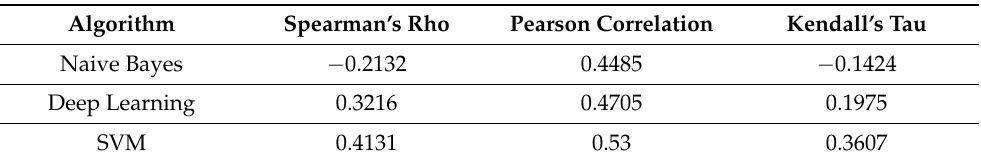
Table 4. The results of validation of the estimated damage map from Naive Bayes, SVM, and deep learning at the city scale.